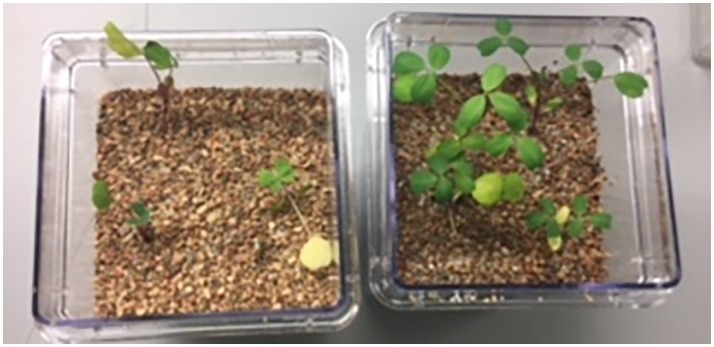
Growth stimulation of alfalfa seedlings in soil in the presence of 1% salt. Uninoculated control (LB media without bacteria), left. Inoculation with the Bacillus isolate, right.